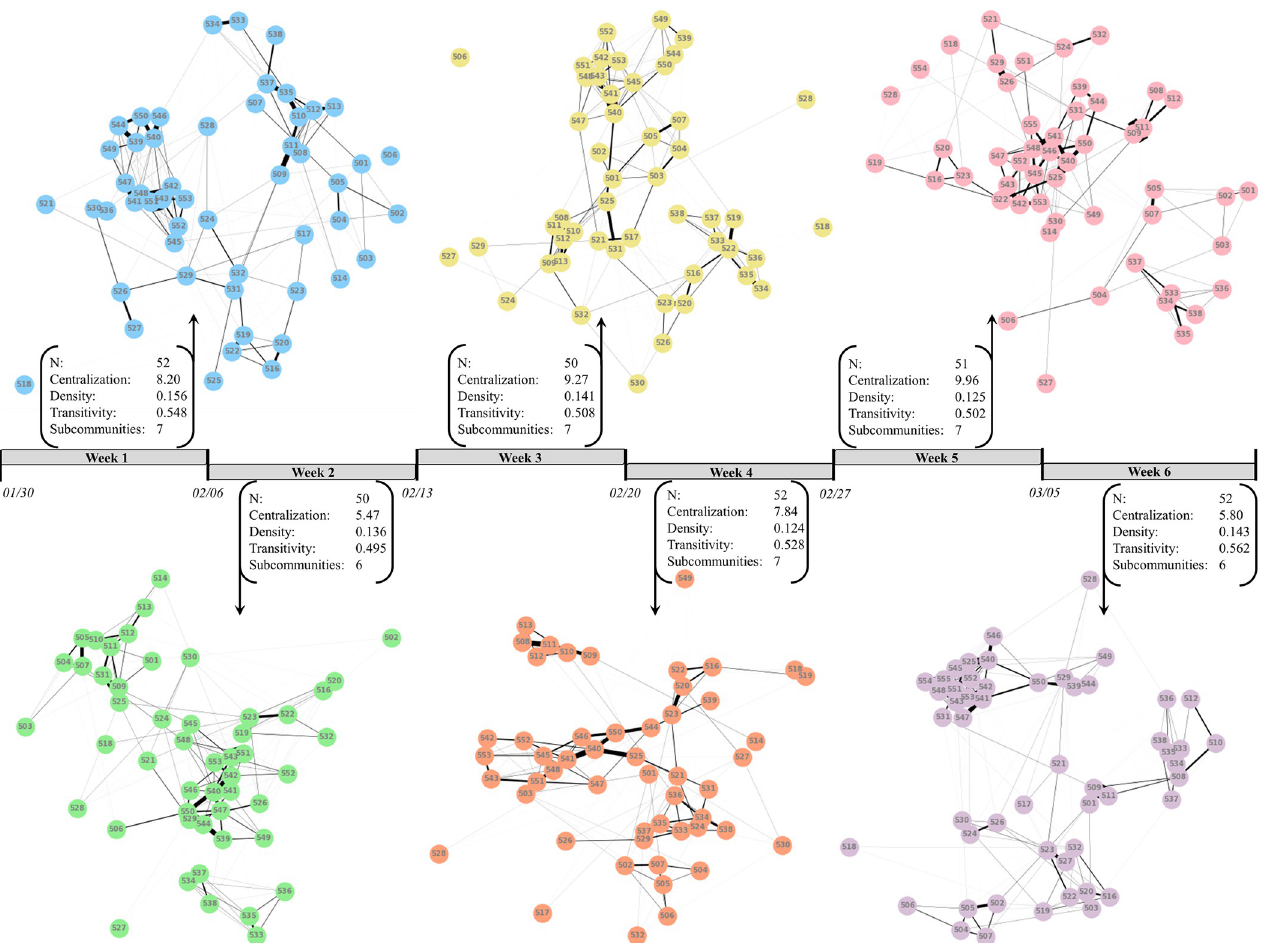
Fig 2. Weekly undirected weighted networks of interactions. Each of the six social networks represent summed infrared-detected interactions (undirected weighted edges) with individuals (nodes) across all work hours (Monday-Friday) for a given week. Nodes are labeled by participant ID and are consistent across networks. Edge thickness scales positively with the number of interactions. Summative network statistics of total number of nodes (N), degree centralization, density, transitivity, and the number of subcommunities are provided for each network.